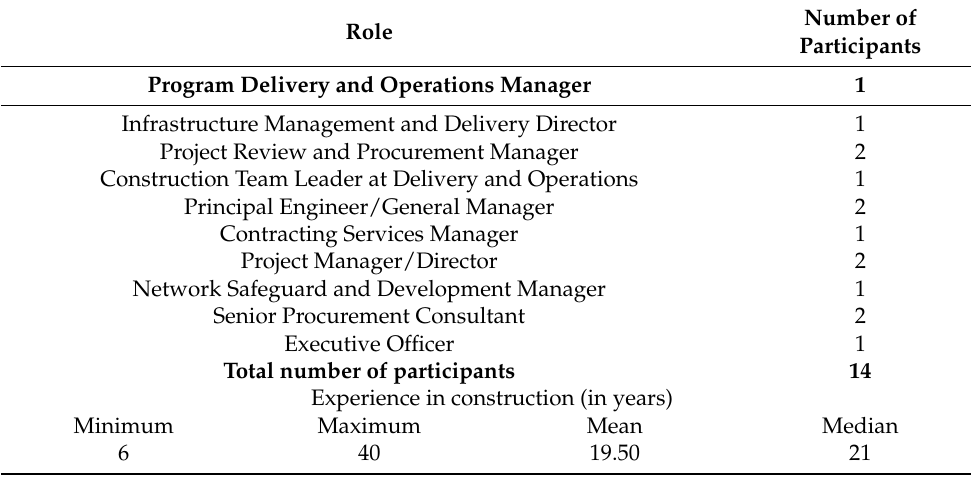
Table 1. Overview of research